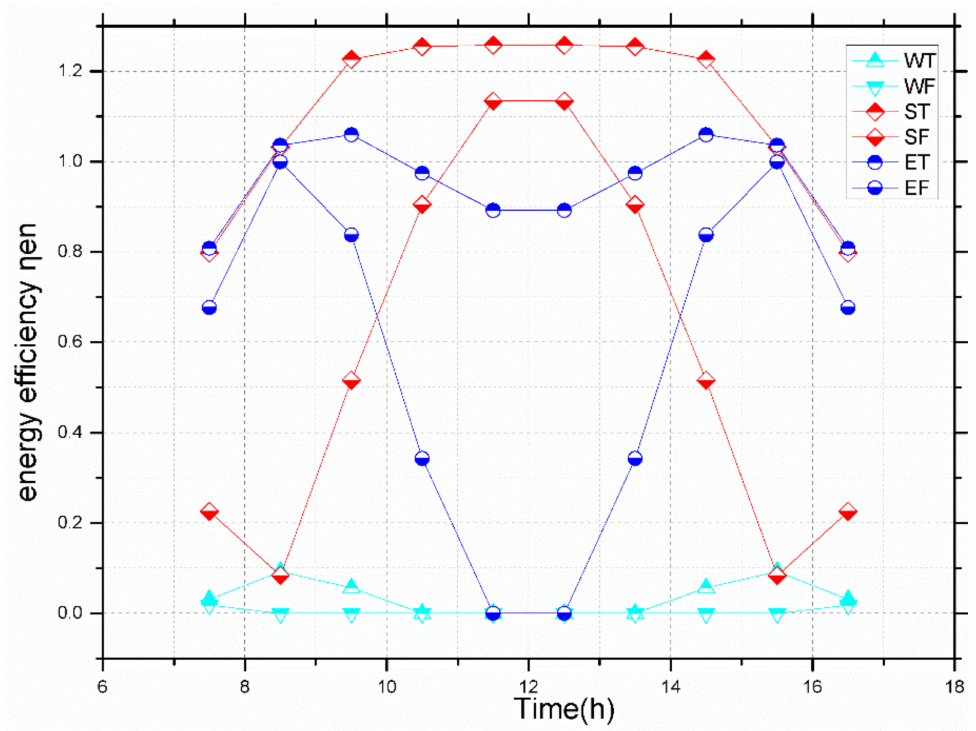
Figure 7. Variation in the reflector optical efficiency with time for the following parameter combina- tion: ϕ = 37.5, α = 20 ◦ , h = 0.4 m, d = D = 1.74